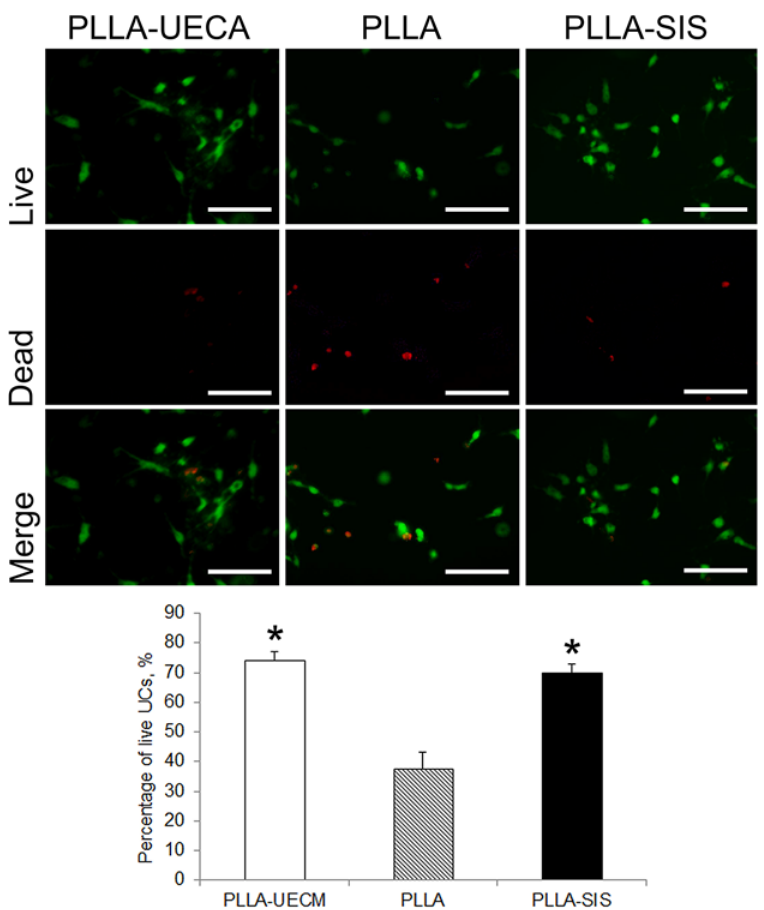
Fig 2. Live/dead staining was used to analyze the fates of the seeded cells. The number of surviving cells on the PLLA-UECM and PLLA-SIS scaffolds were significantly higher than that on the pure PLLA scaffold ( p < 0.05). Inset scale bar = 100 μ m. * : p < 0.05 compared with the PLLA